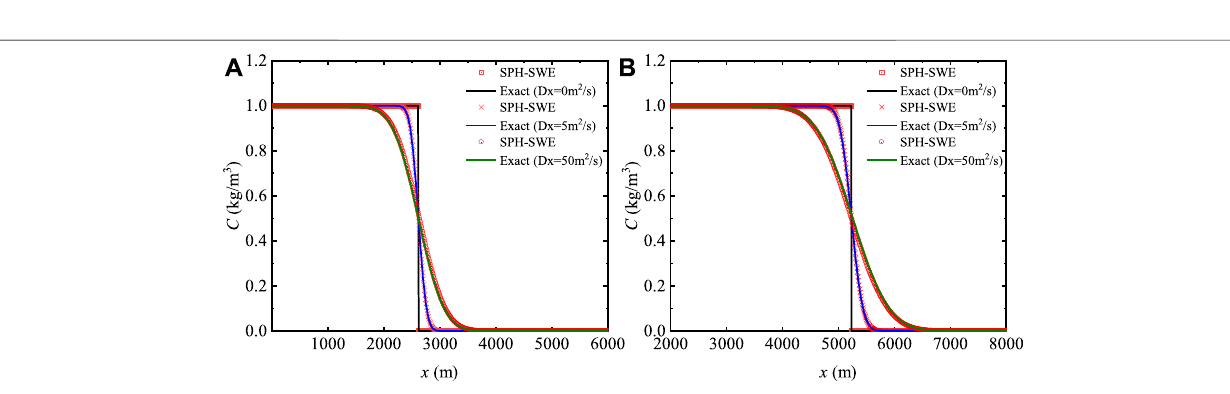
FIGURE 2 | Comparison of analytical solutions and SPH-SWE simulation results of a 1-D time-continuum distribution source. (A,B) Concentration distribution (t = 1300 s and 2600 s